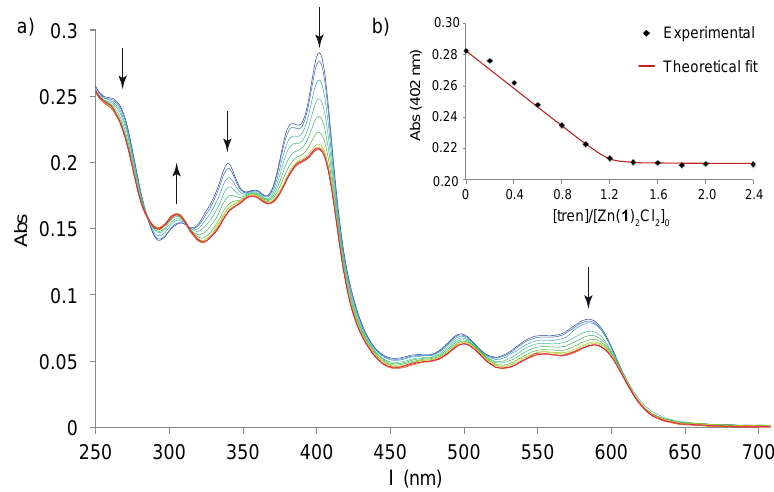
Figure 6. a ) UV-Vis titration of [Zn( 1 ) 2 ]Cl 2 (5.0 × 10 −6 mol·L −1 ) upon the addition of tren in CHCl 3 , after Figure 6. ( a ) UV-Vis titration of [Zn( 1 ) 2 ]Cl 2 (5.0 × 10 − 6 mol · L − 1 ) upon the addition of tren in CHCl 3 , the opening with 0.5 equivalent of ZnCl 2 and b ) Absorption at 402 nm and fitting with a 1:1 binding after the opening with 0.5 equivalent of ZnCl 2 and ( b ) Absorption at 402 nm and fitting with a 1:1 model. binding